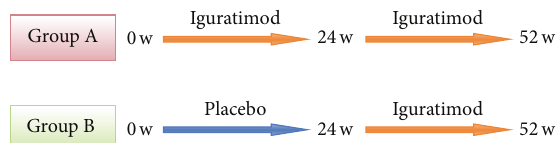
Figure 1: The difference of administration between groups A and